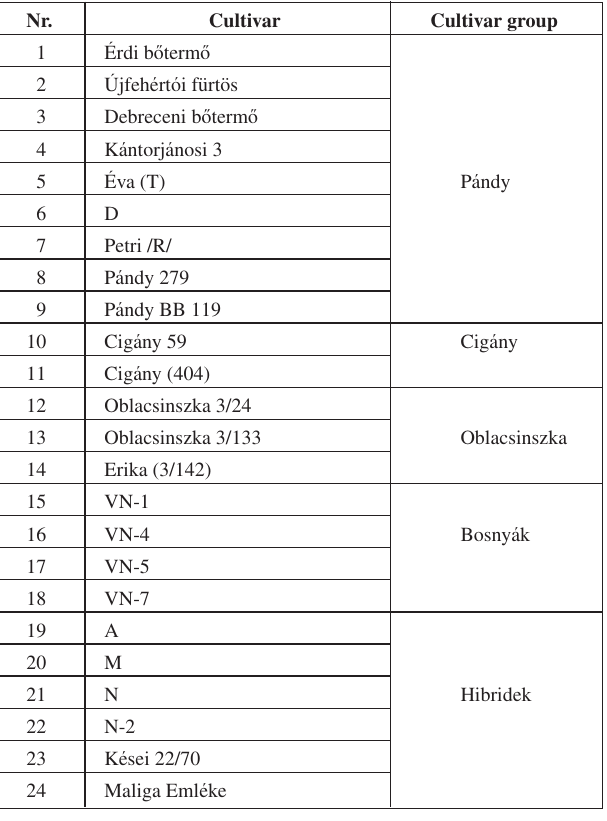
Table 1. The sour cherry genotypes used